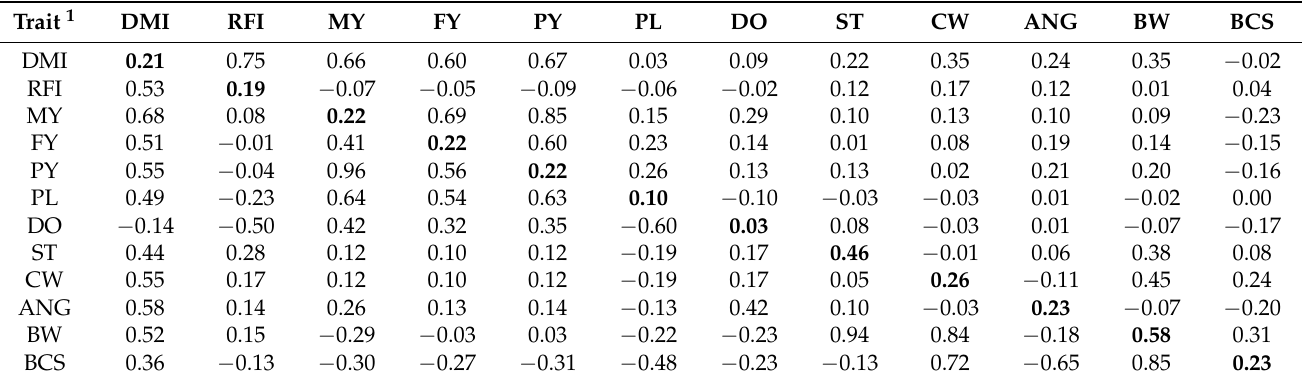
Table 3. Heritabilities (diagonal, bold) and phenotypic (above diagonal), and genetic (below diagonal) correlations of feed efficiency, production, reproduction, longevity, type, body weight, and body condition score traits used from meta-analysis to calculate optimal selection index weights for selection criteria